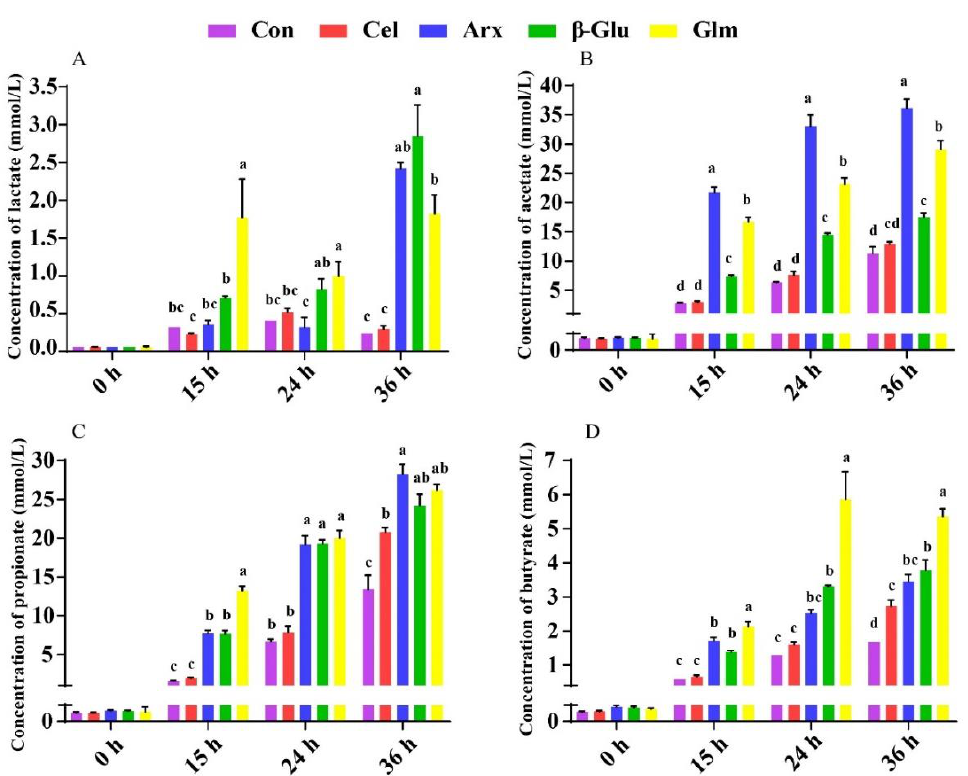
Figure 4. Quantification of lactate ( A ), acetate ( B ), propionate ( C ), and butyrate ( D ) in the fermentation broth of five groups at 0, 15, 24, 36 h during fermentation. All data were analyzed by the one-way ANOVA with Tukey’s post− hoc test and presented as the mean values ( n = 5; Different letters mean p < 0.05; Con, control; Cel, cellulose; Arx, arabinoxylan; β − Glu, β − glucan; Glu, glucomannan).